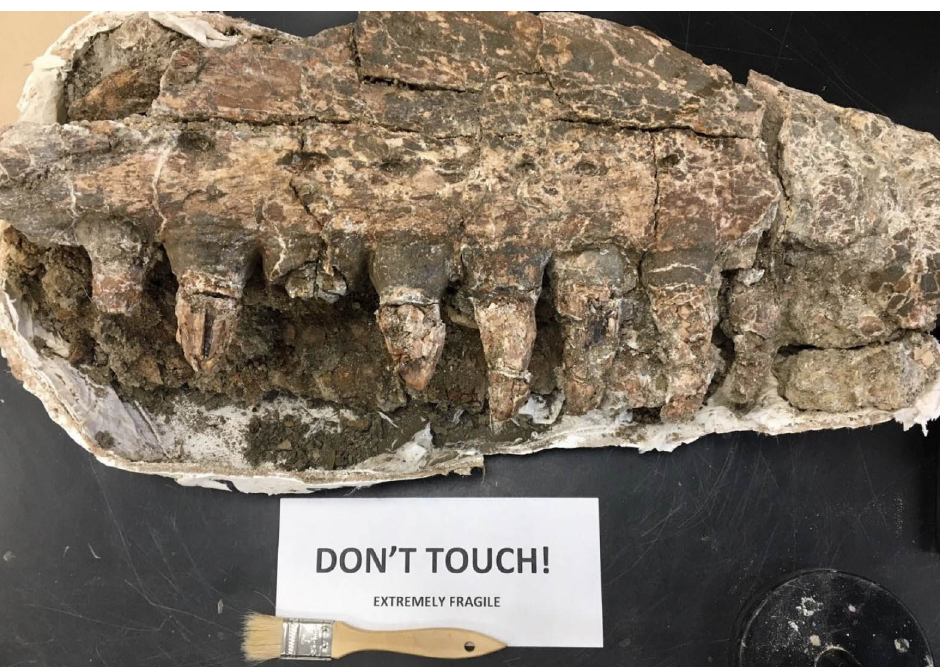
Figure 1. Right maxilla of RSKM P3194.1, a large specimen of Proganthodon overtoni from Grasslands National Park,